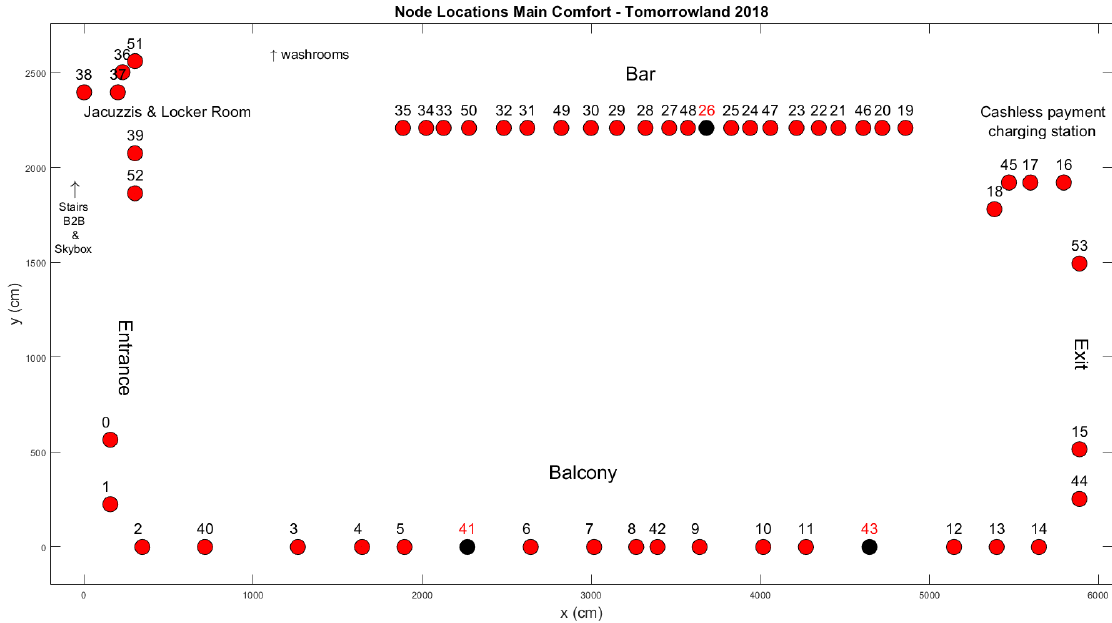
Figure 2. An overview of the Main Comfort